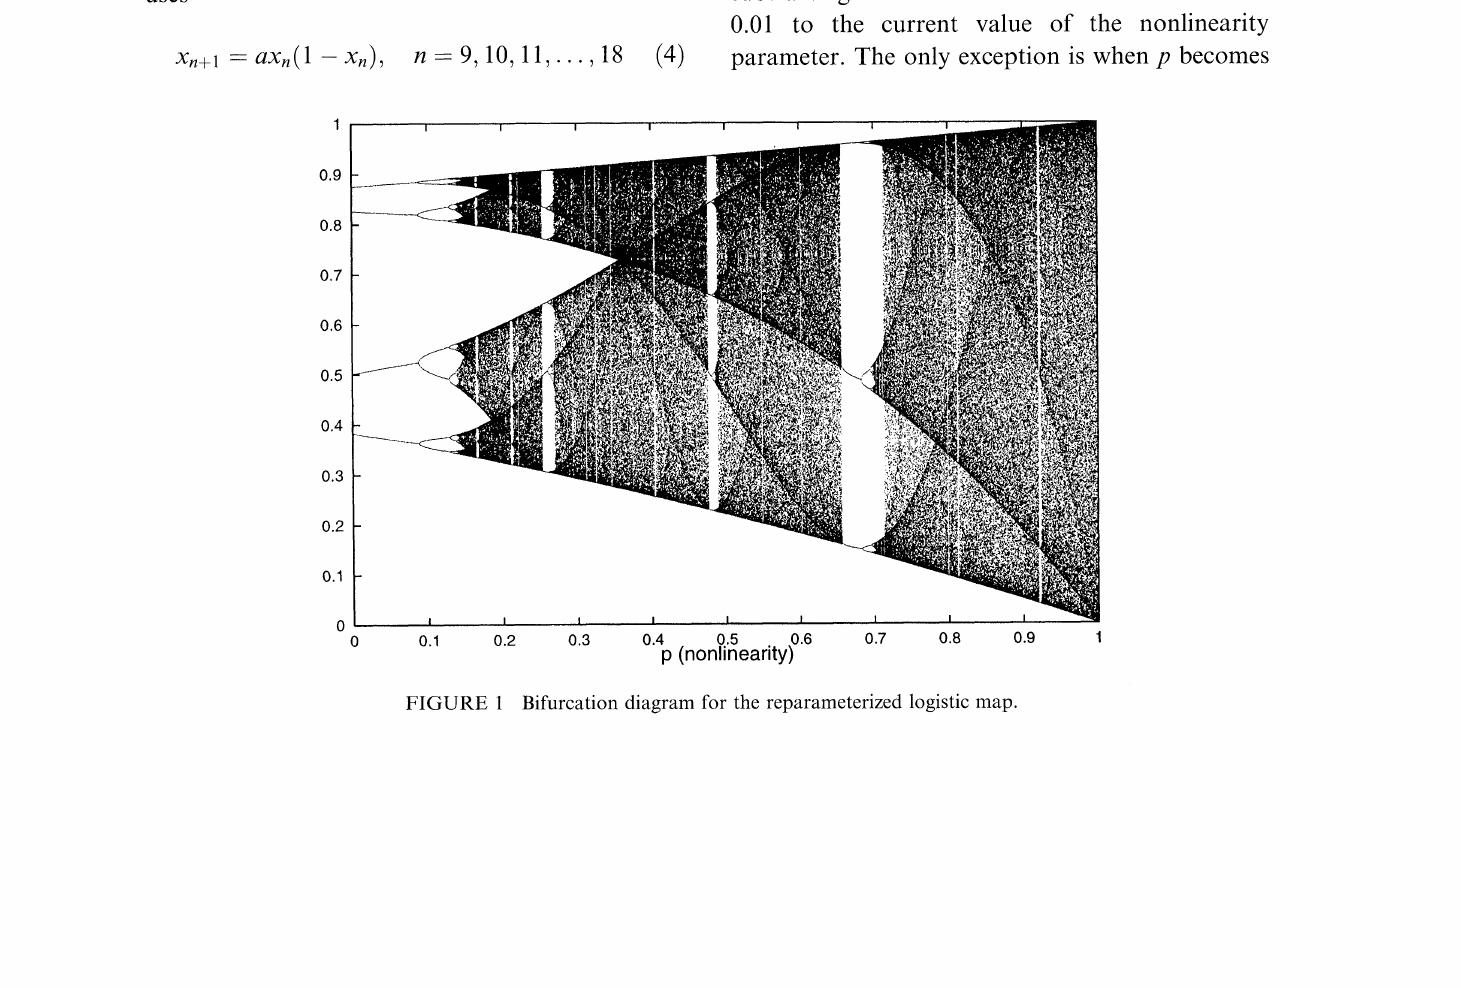
Bifurcation diagram for the reparameterized logistic